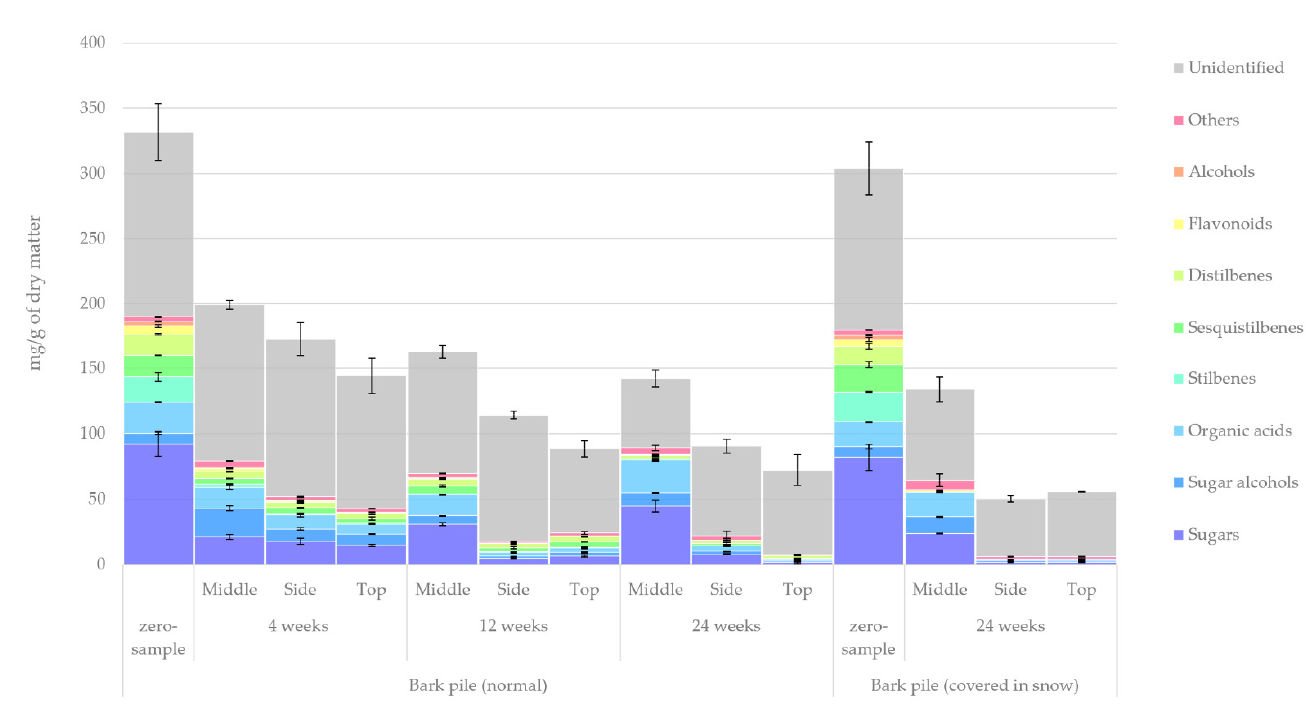
Figure 4. Hydrophilic extractive groups in bark samples during pile storage.